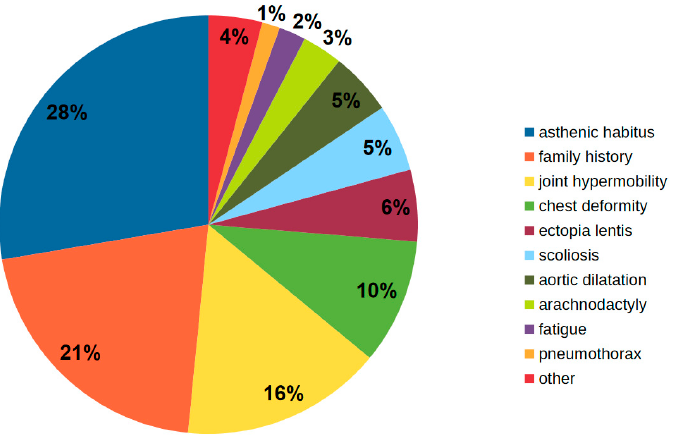
Figure 1. Diagram presenting reasons for Marfan syndrome suspicion.